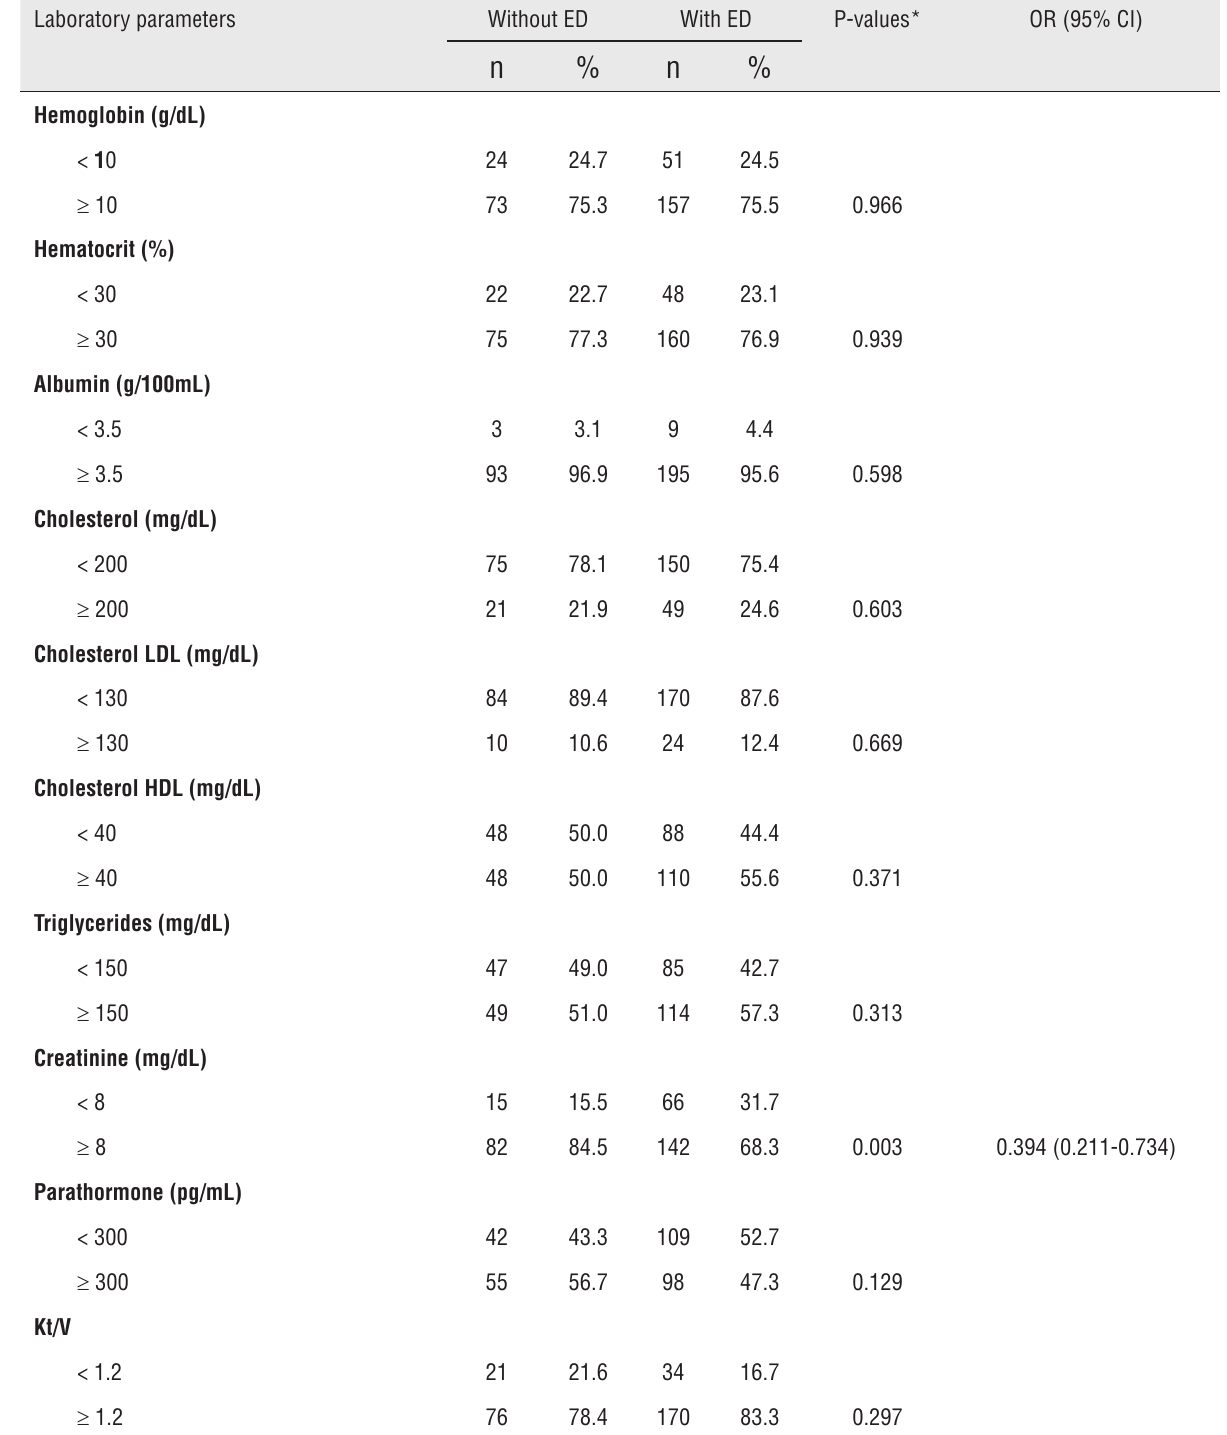
Table 5 - Association of laboratory values and Erectile Dysfunction in hemodialysis patients. Laboratory parameters Without ED With ED P-values* OR (95% CI) n % n